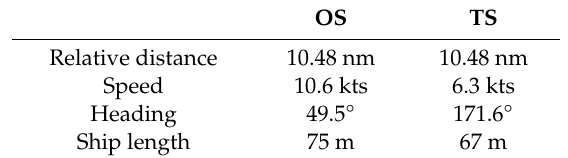
Table 3. Initial parameters in numerical simulation.